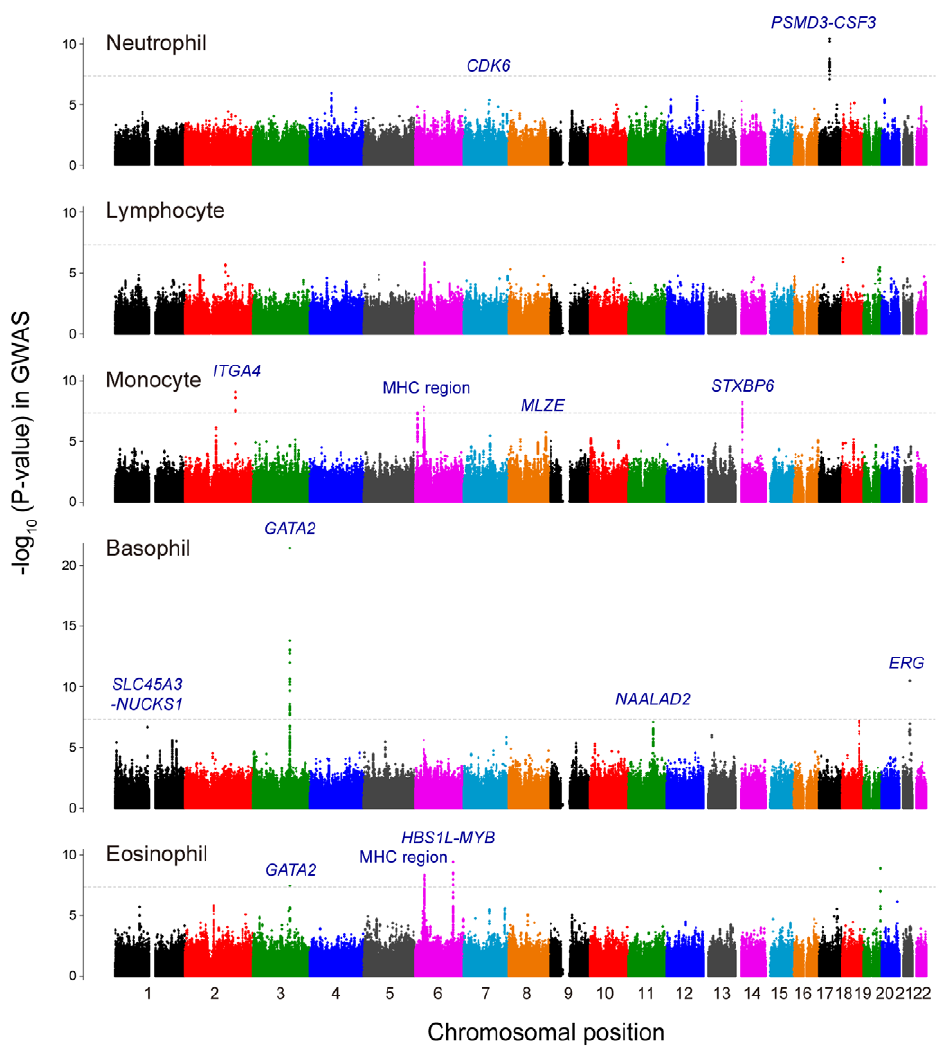
Figure 1. Manhattan plots of the GWAS for the WBC subtypes. Manhattan plots showing the -log 10 (P-values) of the SNPs in the GWAS for neutrophil, lymphocyte, monocyte, basophil, and eosinophil counts. The genetic loci that satisfied the genome-wide significance threshold of P , 5.0 6 10 2 8 in the combined study of the GWAS and the replication study were labeled in each of the traits. The gray horizontal line represents the threshold of P =5.0 6 10 2 8